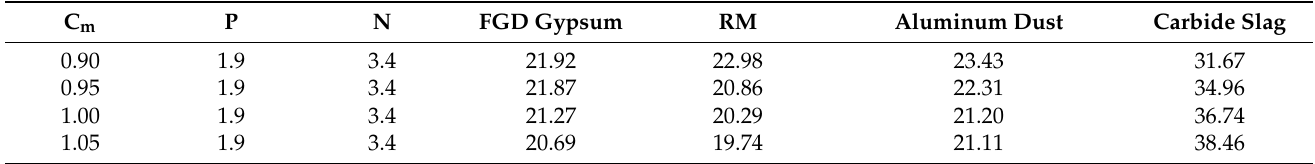
Figure 1. XRD pattern of raw materials ( a ): red mud (RM), ( b ): FGD gypsum, ( c ): aluminum dust, ( d ): carbide slag. Table 3. Compositions and parameters of the raw material (wt. %).